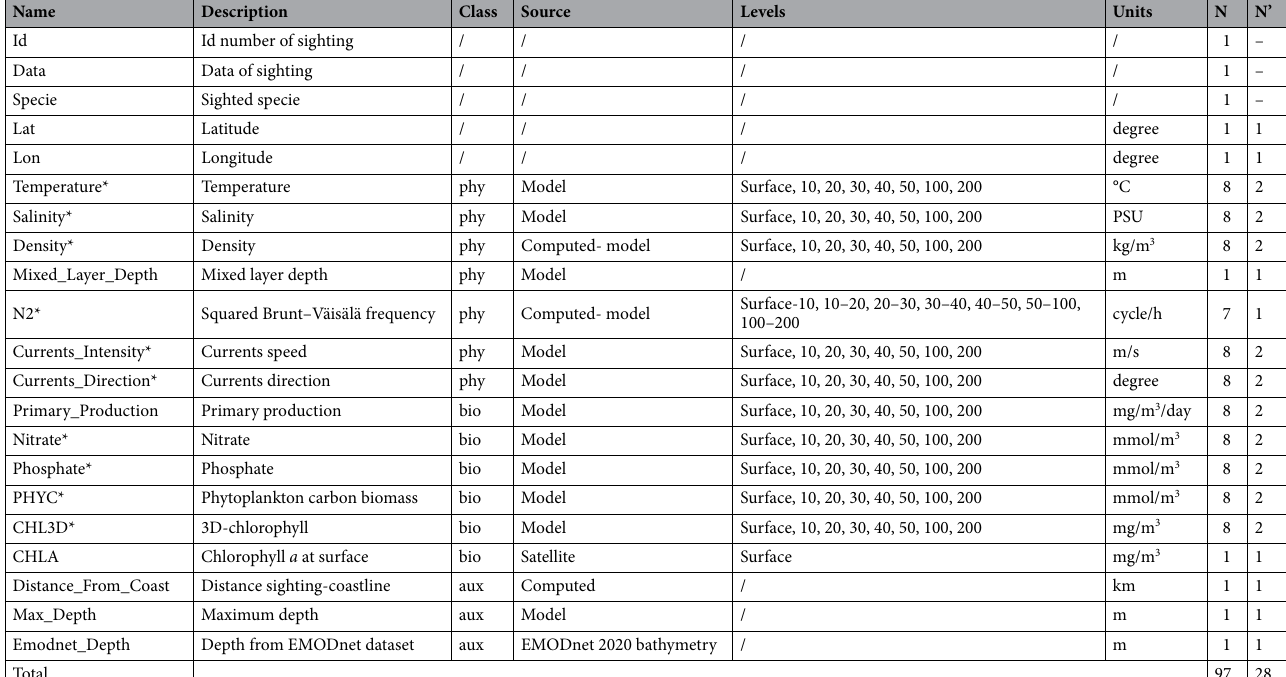
Table 5. List of the 97 features used in this study. The header specifies the variable Name and its long description header. The variable class distinguishes physical (phy), biogeochemical (bio) and auxiliary features. The source header describes the origin of the data (satellite, model, or computed from model data). The level header represents the depth at which data are provided. The column units contain the units of measurement. The Column N refers to the number of features available, while N’ refers to the number of variables used to train machine learning algorithms. The * symbol refers to three-dimensional